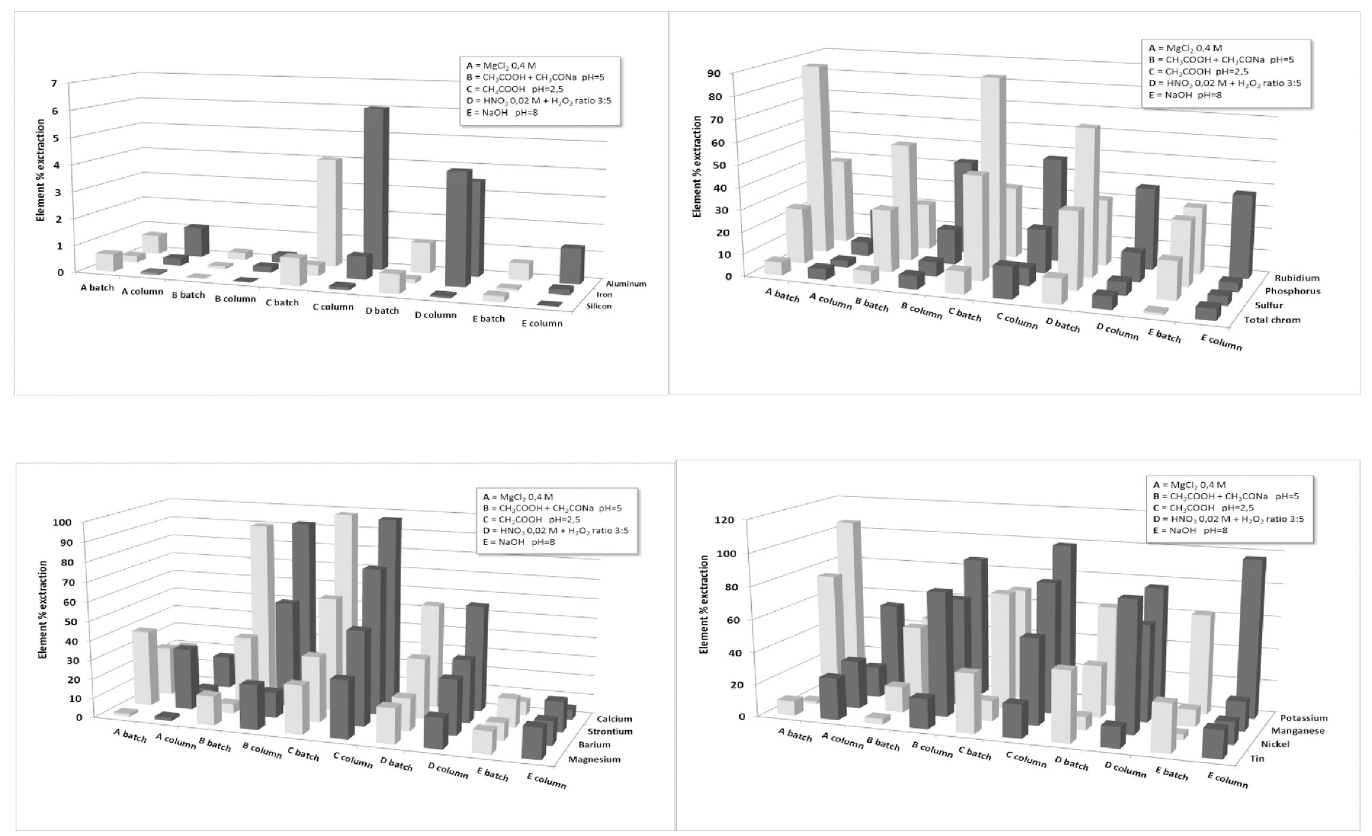
Fig 1. Comparison between the total % extraction of every leachant (A = 0.4M MgCl 2 pH 6.5; B = CH 3 COONa pH 5; C = CH 3 COOH pH 2.5; D = 0.02M HNO 3 and 30% H 2 O 2 (ratio 3:5) pH < 1; E = NaOH pH 8) in batch extraction test and that obtained in column percolation test.